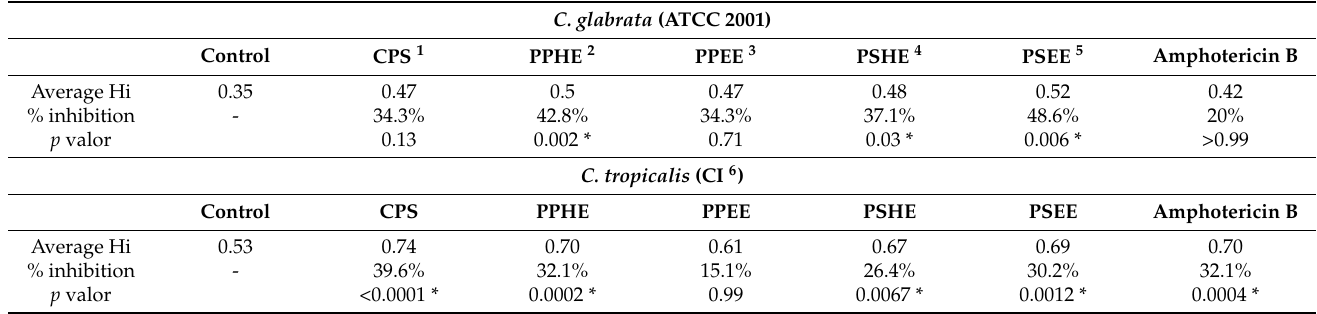
Table 2. Hemolytic index and percentage of hemolytic activity inhibition for C. glabrata (ATCC2001) and C. tropicalis (CI) after exposure to 1 ⁄ 2 MIC of capsaicin, hexane and ethanolic extracts from Capsicum chinense Jacq. peel and seeds, and amphotericin B.